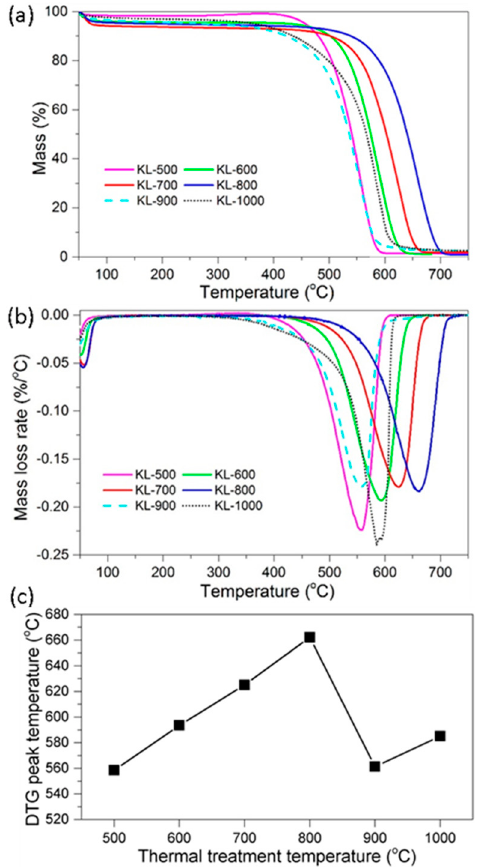
Figure 6. Thermal stability analysis of KL-X samples: ( a ) mass loss TG and ( b ) mass loss rate DTG curves of KL-X samples oxidized in air atmosphere; and ( c ) and influence of KL-X samples production temperature on its DTG peak temperature.